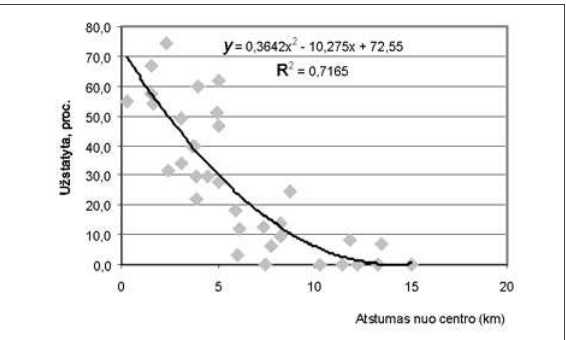
Fig 2. Regression line between greenery area per capita and distance from city center